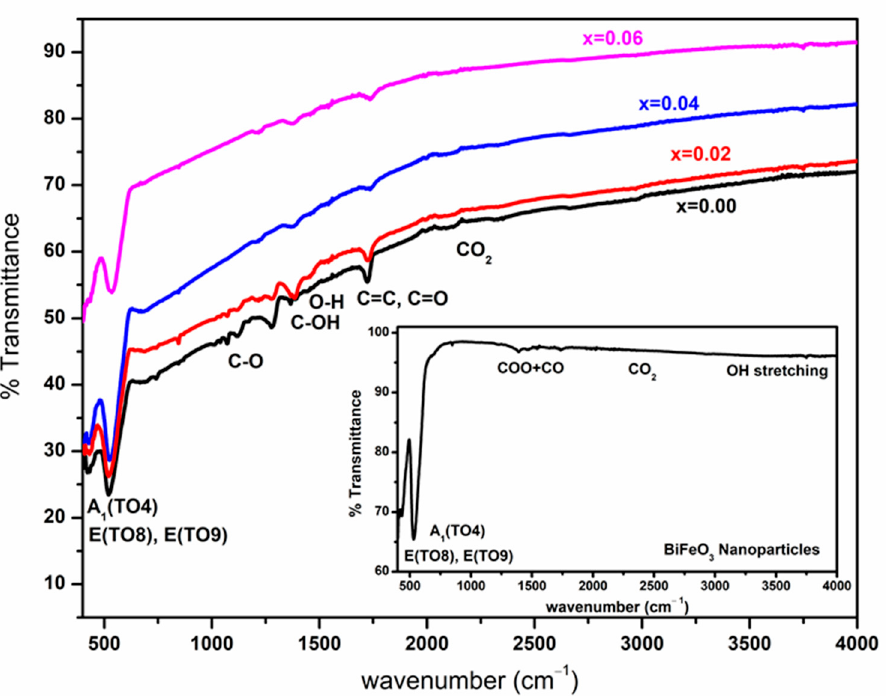
Figure 5. FTIR transmittance spectra of [BiFe 1 − x Li x O 3 ]-graphene nanocomposite. The inset shows the FTIR transmittance spectra of BiFeO 3 nanoparticles.